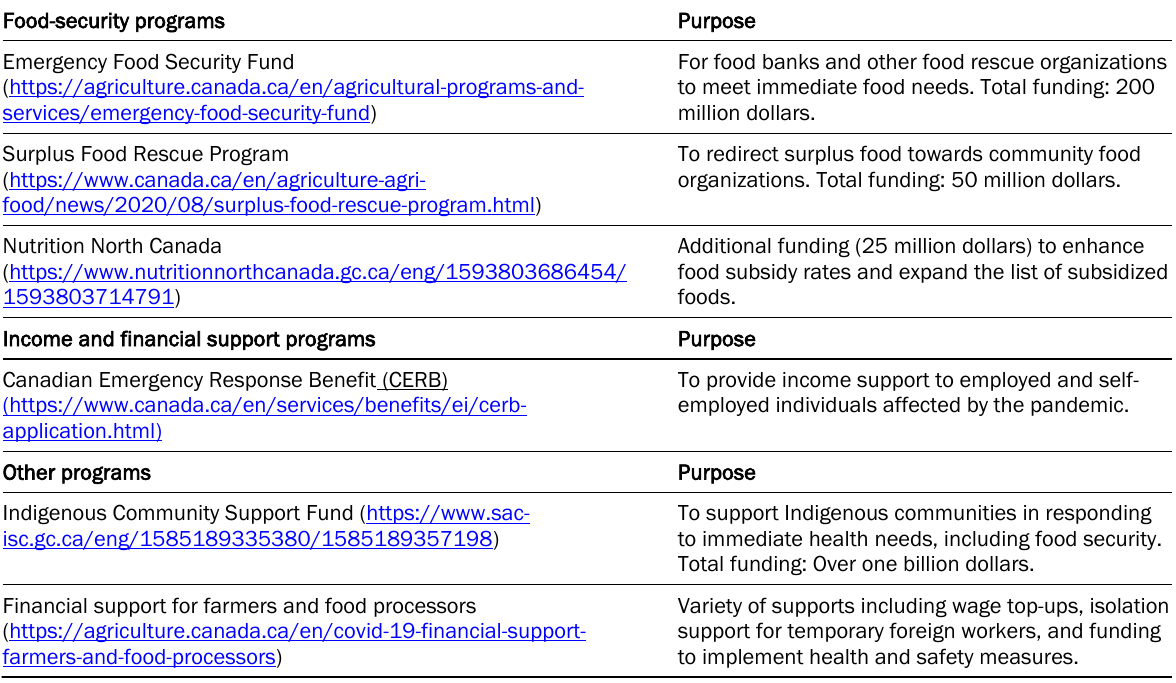
Table 2. Policy Responses from the Federal Government Food-security